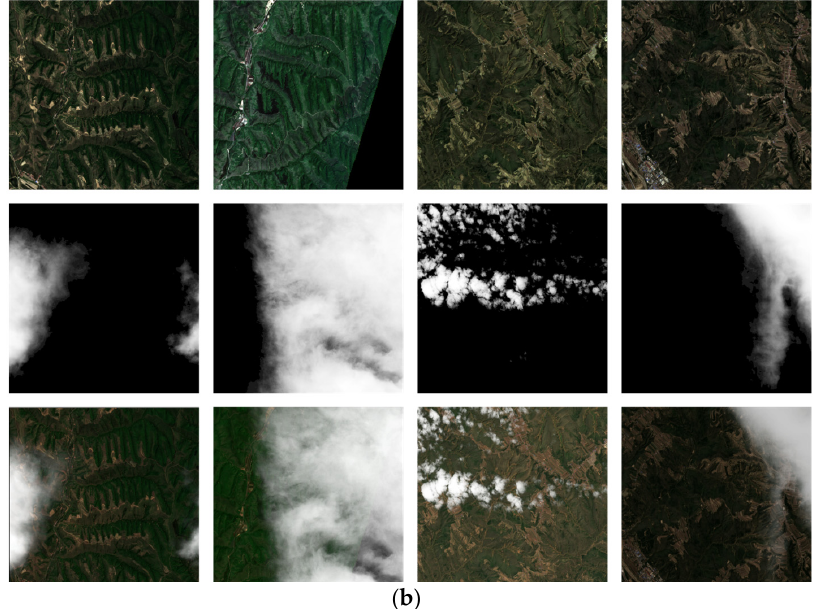
Figure 1 ( a ) Pixel value statistics of red, green, and blue wave segments in Sentinel-2’s cloud region. Two sets of linear regression calculations were carried out based on the red band, and the values of 4000–8000 pixels were instantiated. ( b ) dataset generation for cloud matting. The first row contains the bottom image of a Sentinel-2 RS image without clouds (Background); the second row is foreground pixel reflection intensity multiplied by the cloud opacity (Foreground); the third row contains the generated RS image with clouds.